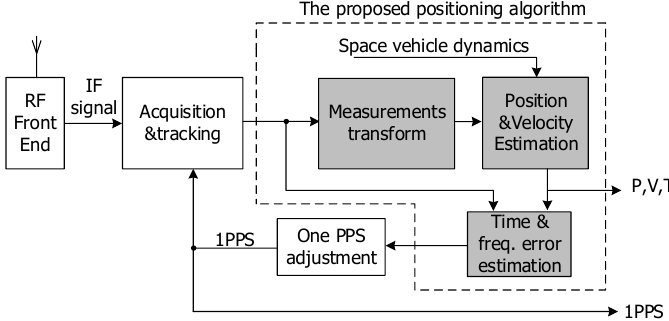
Figure 4. Signal processing flow of a space-borne GNSS receiver with the proposed